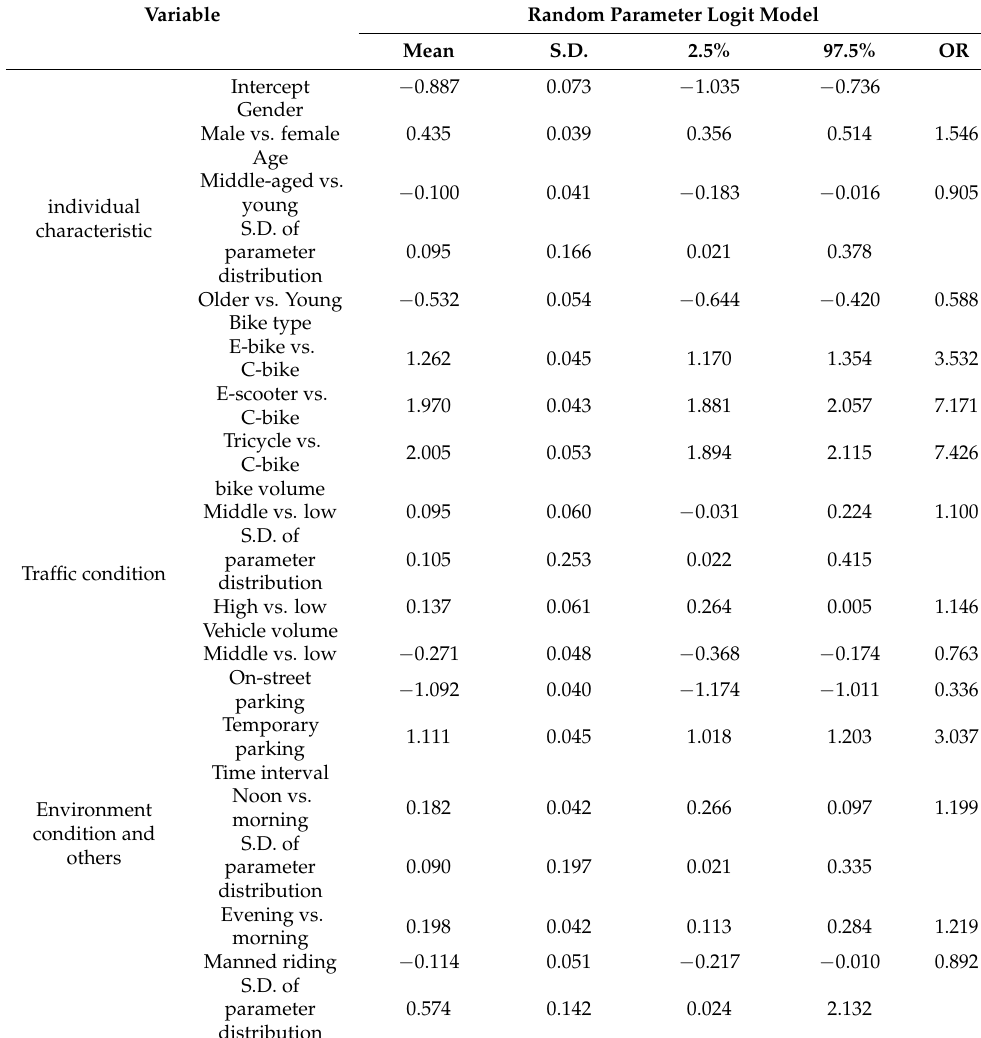
Table 7. Estimation from the Bayesian random parameters logit model at bike lanes separated with